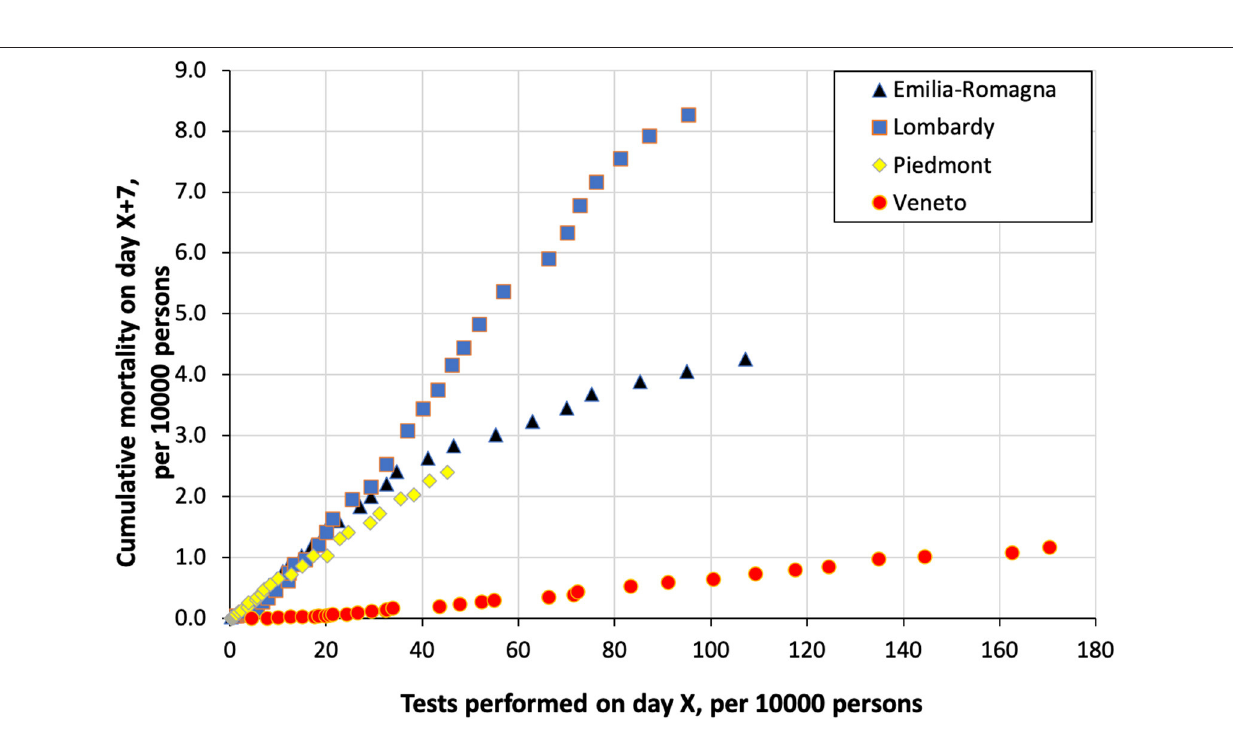
Frontiers in Medicine | www.frontiersin.org